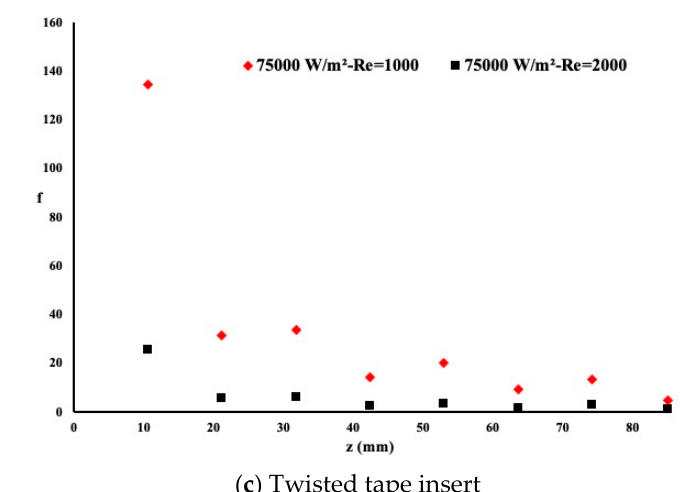
Figure 8. Friction factor along the pipe length.